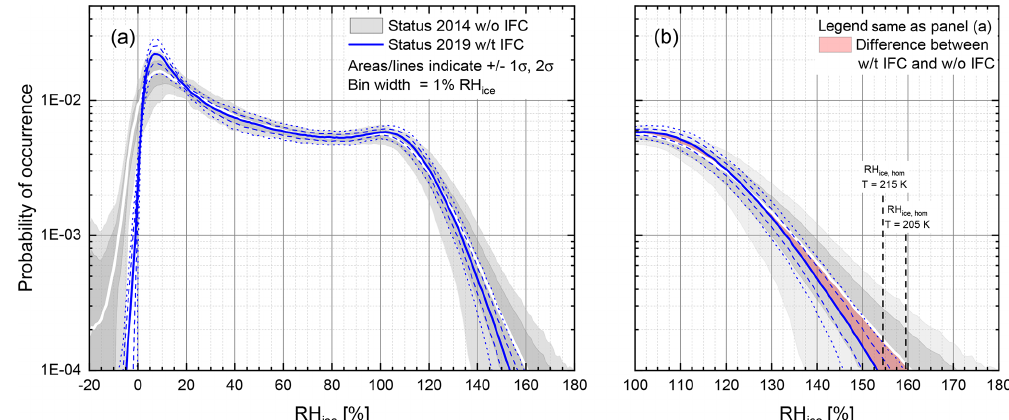
Figure 3. Averaged probability density functions of RH ice for the entire MOZAIC period from 1995 to 2010 (a) and the zoomed in region of ice supersaturation (b) . Data stem from the reanalysis (Smit et al., 2014) without (w/o: white line, grey areas) and with (w/t: blue lines) the in-flight calibration method applied to the data. The red-shaded area indicates the difference between IFC applied (w/t IFC) and not applied (w/o IFC), and vertical lines indicate the threshold RH ice values for the homogeneous nucleation of ice at T = 205K and T = 215K (Koop et al., 2000).